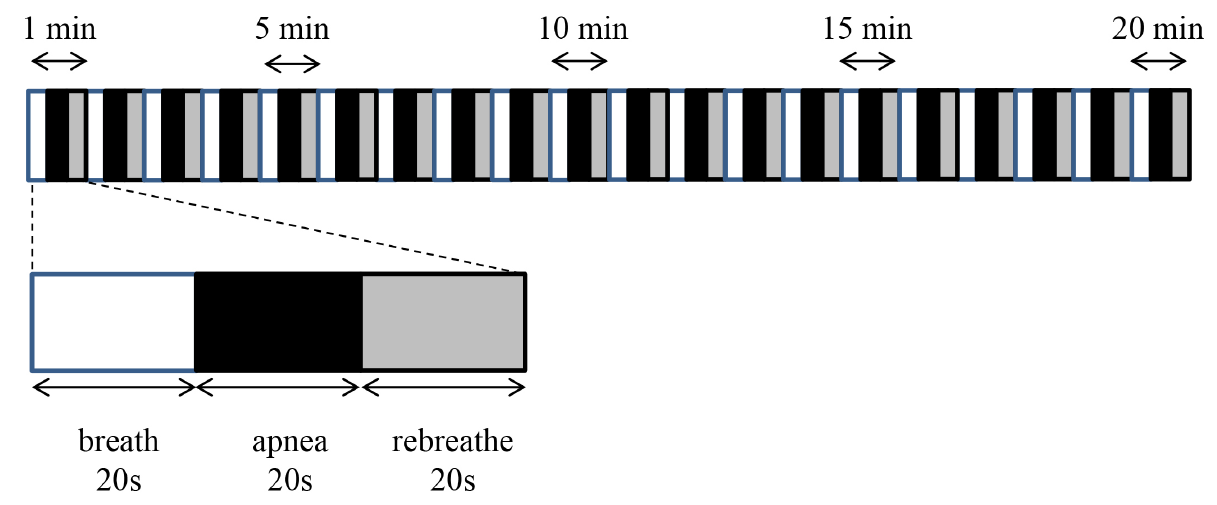
Fig. 1. Diagram of the experimental protocol. The apnea breathing cycle consisted of 20 s of breath, apnea, and rebreathe. Twenty apnea maneuvers were performed over 20 min (one apnea per min). Subjects controlled their “breath” and “rebreathe” in time to a metronome set at a pace of 15 breaths/min.